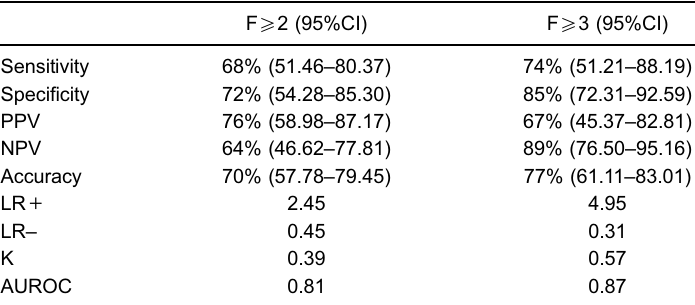
Table 3. Transient elastography performance indicators for signi fi cant (F X 2) and advanced (F X 3) fi